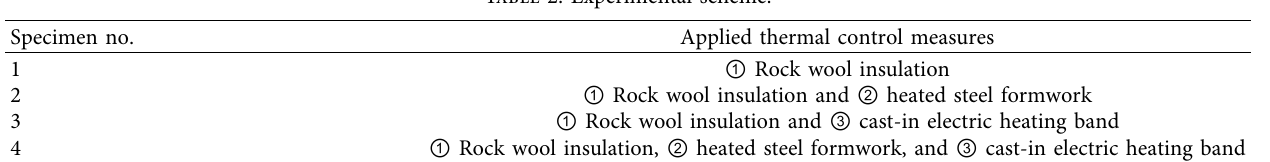
Table 2: Experimental scheme.